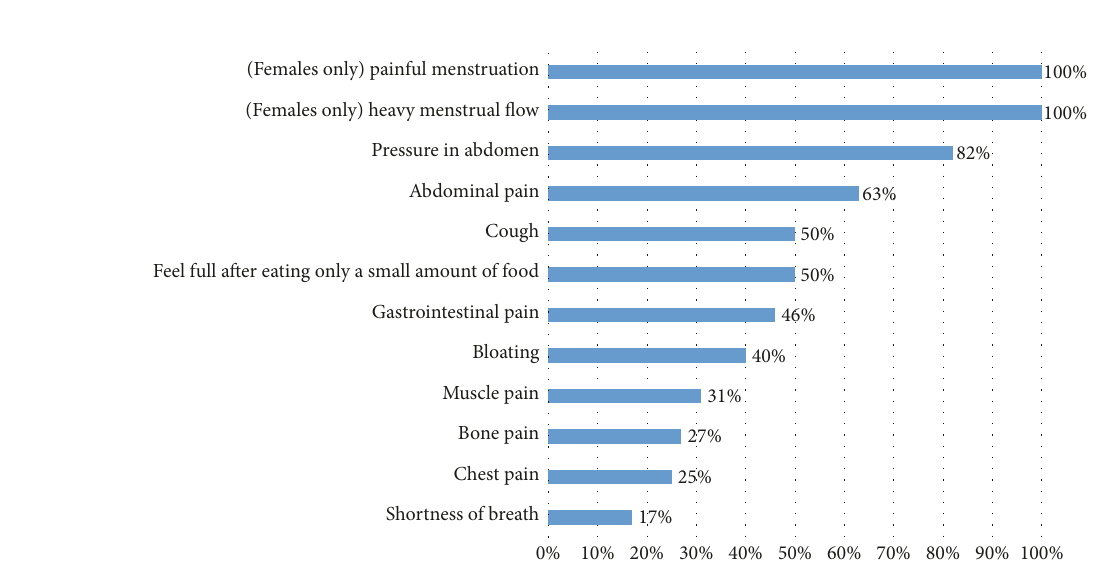
Figure 2: Web survey results for participants reporting symptom as tumor